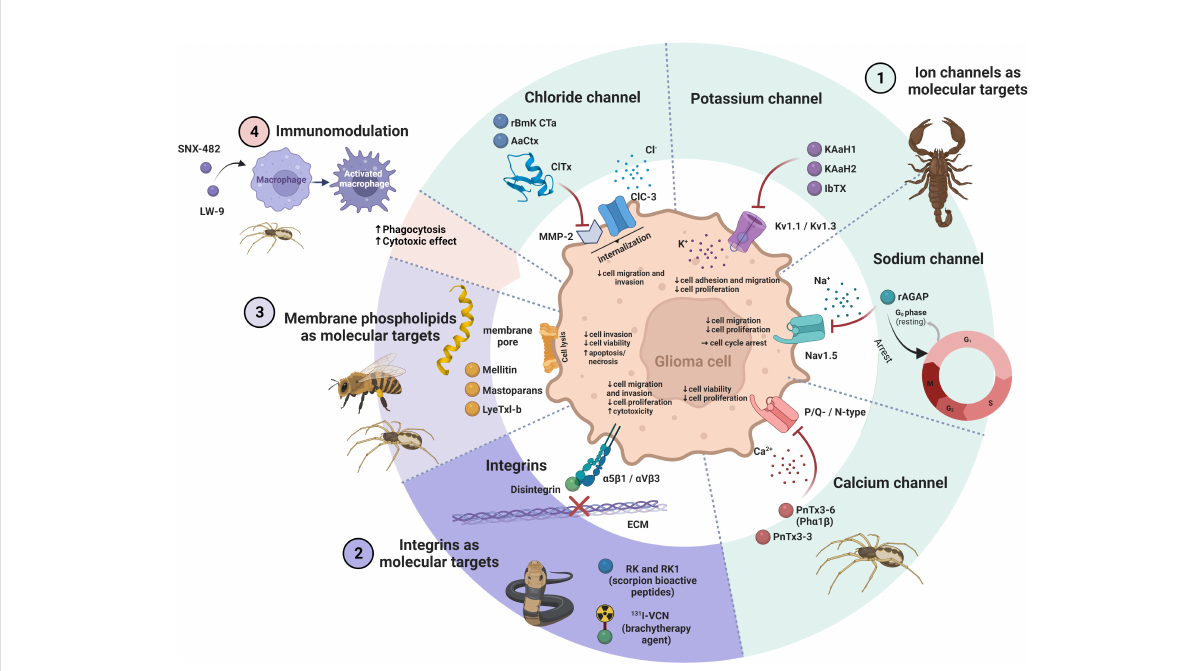
FIGURE 2 The ways of action of venom peptides on glioma cell. 1.) Venom peptides block different ion channels in glioma cells, such as Cl − , K + , Na + and Ca 2+ resulting in a decrease in viability, proliferation and invasion of the cells. 2.) Venom peptides ( e.g. disintegrins) bind to integrins and inhibit their interaction with the ECM. This impairs migration and proliferation of glioma cells and induce cell death. 3.) Venom peptides that interact with phospholipids in the plasma membrane of glioma cells disturb its integrity with the result of perforation of the membrane leading to cell lysis and death. 4.) The immunomodulatory effects of venom peptides on macrophages may enhance their cytotoxic and phagocytic effect on glioma cells. The fi gure was created using BioRender online tool